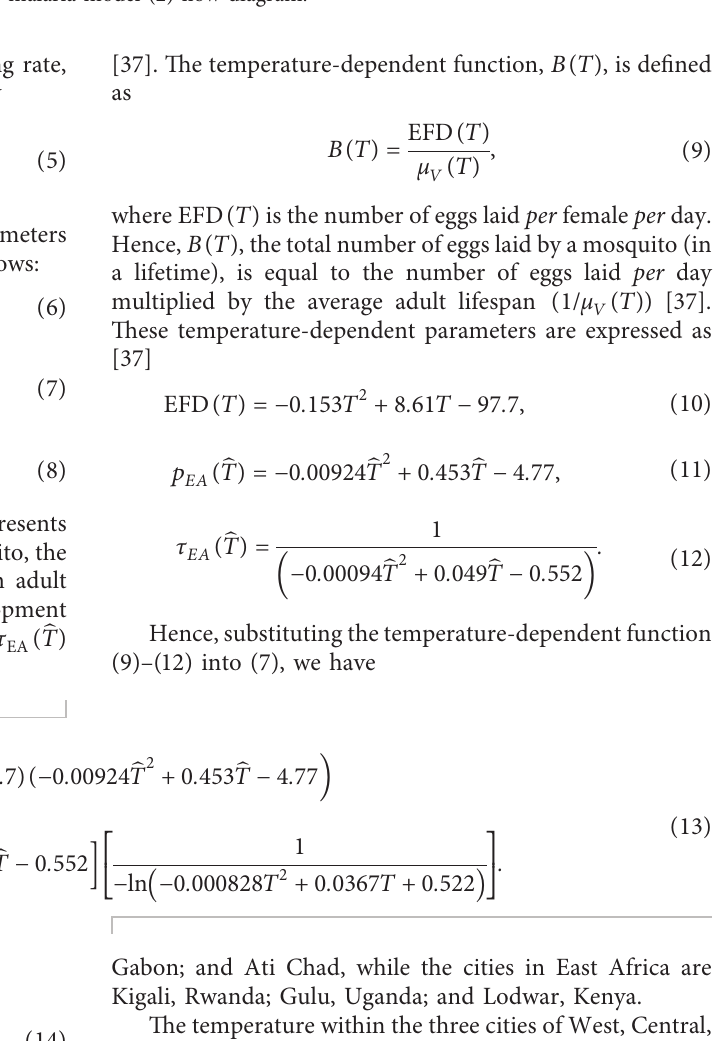
Figure 1: The malaria model (2) flow